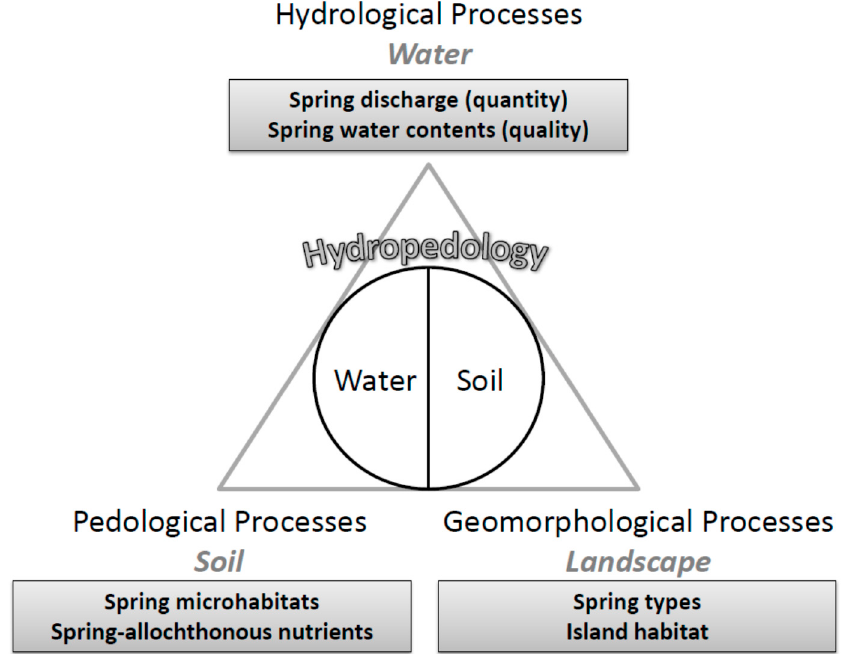
Figure 3. Hydropedology as an interdisciplinary science in the context of spring ecology (modified after [35]).